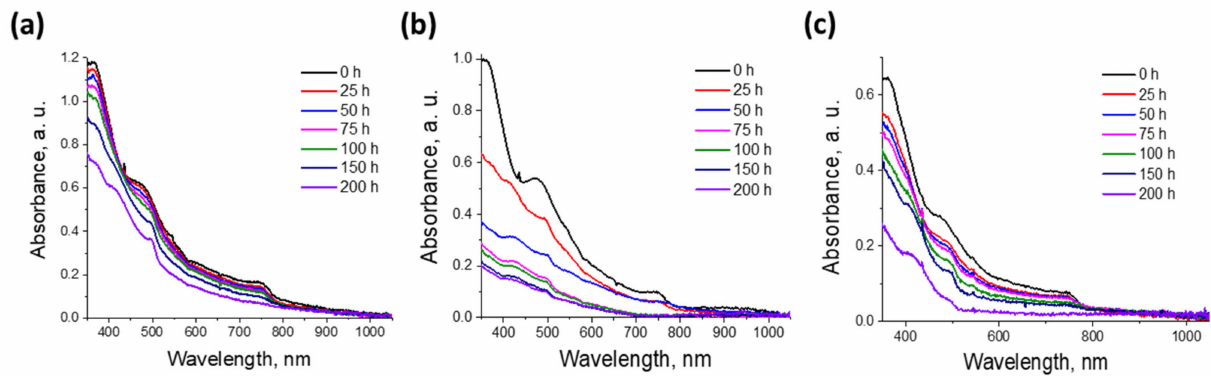
Figure 2. The evolution of the UV-vis spectra of MAPbI 3 films grown on ( a ) glass, ( b ) ITO, and ( c ) TiO 2 substrates upon light soaking under anoxic